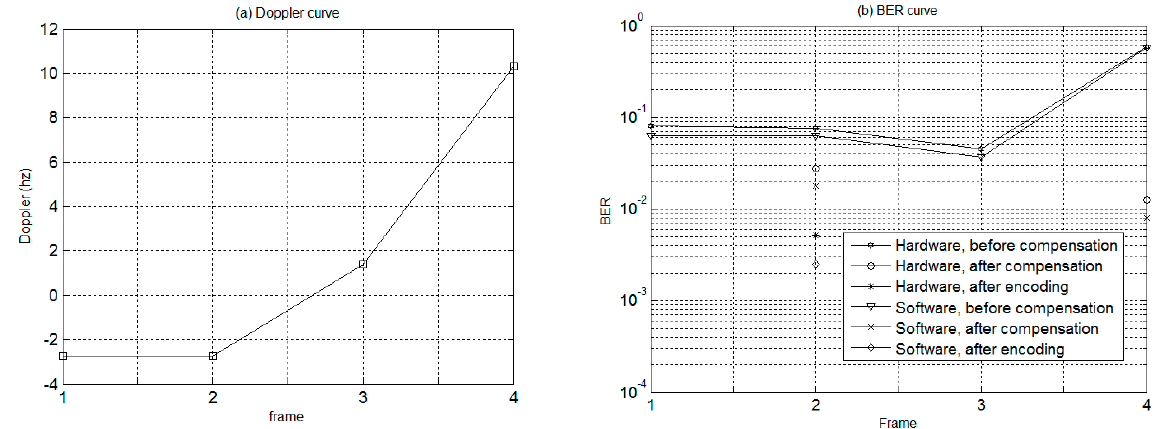
Figure 12. Response of the experimental channel for the second trial.